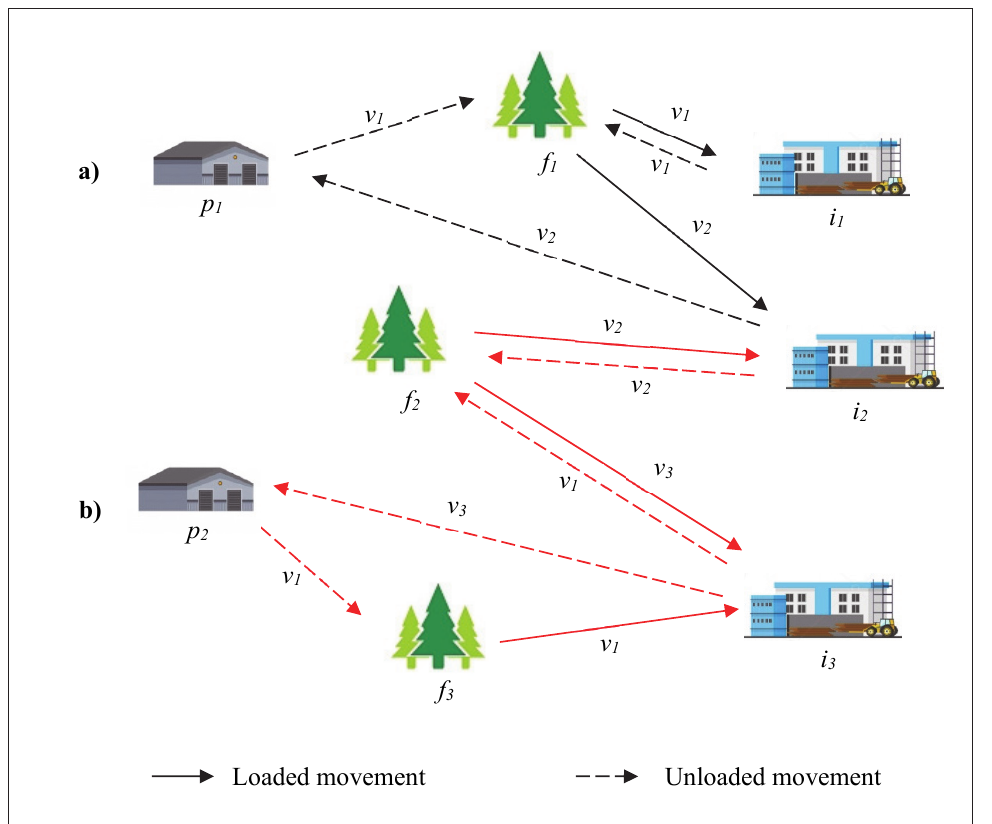
Fig. 2 . Example of routes composed by two (a) and three trips